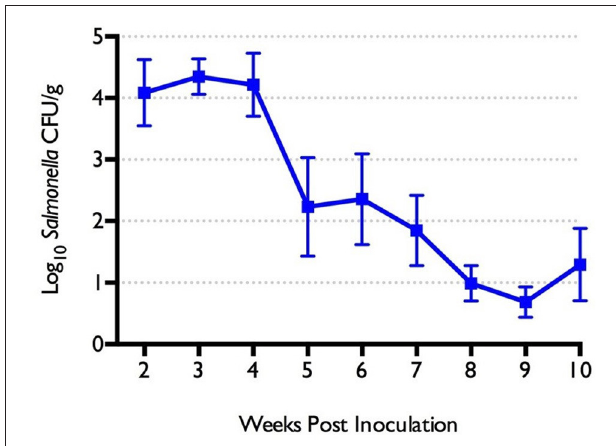
FIGURE 5 | Salmonella cecal shedding (log 10 CFU/g) in turkeys experimentally infected with S . Heidelberg- lux at 1 day of age.